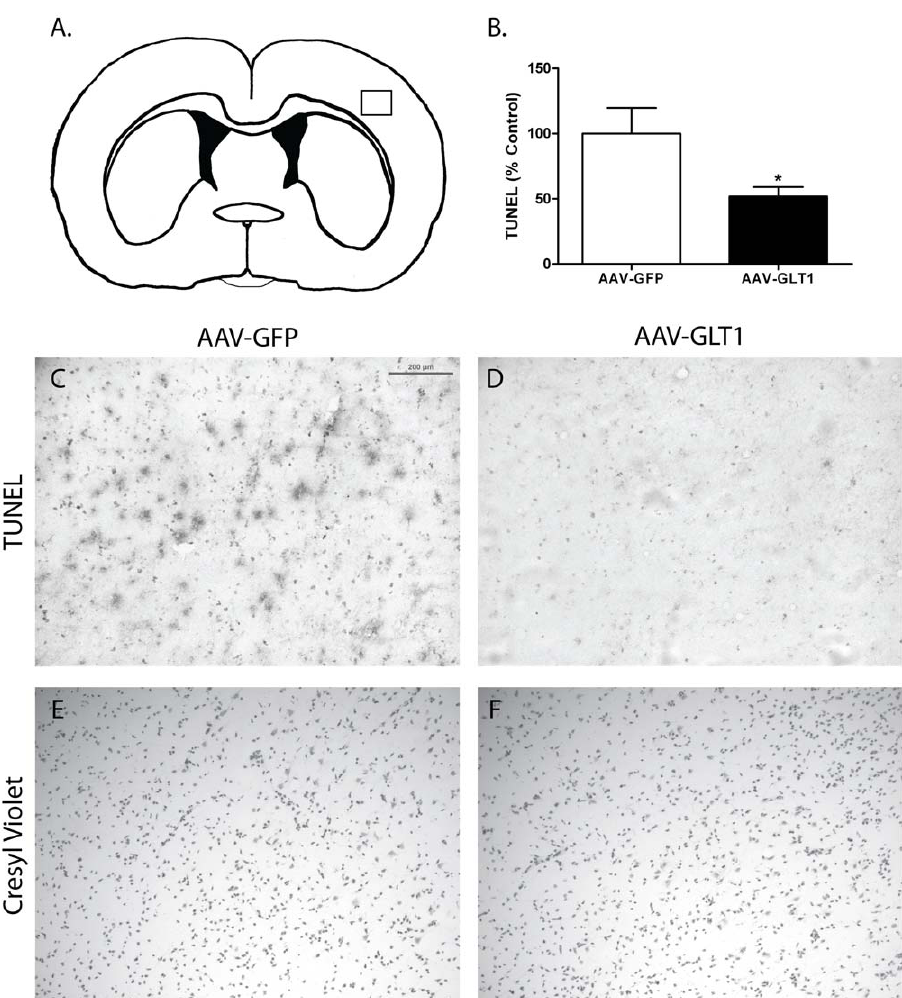
Figure 6. Pre-treatment with AAV-GLT1 reduces TUNEL staining following MCAo. TUNEL was examined at 24 hours after MCAo in the region of infarction near site of viral transduction. (A) Schematic of coronal secion near bregma indicating cortical region (box) of representative images in C–F. (B) AAV-GLT1 significantly reduced TUNEL staining in ischemic cortex compared to AAV-GFP (p , 0.05, Student’s t-test). Representative TUNEL from AAV-GFP (C) and AAV-GLT1(D). Cresyl violet staining in on adjacent brain sections from AAV-GFP (E) and AAV-GLT1(F) treated animals. Scale bar=0.2 mm.